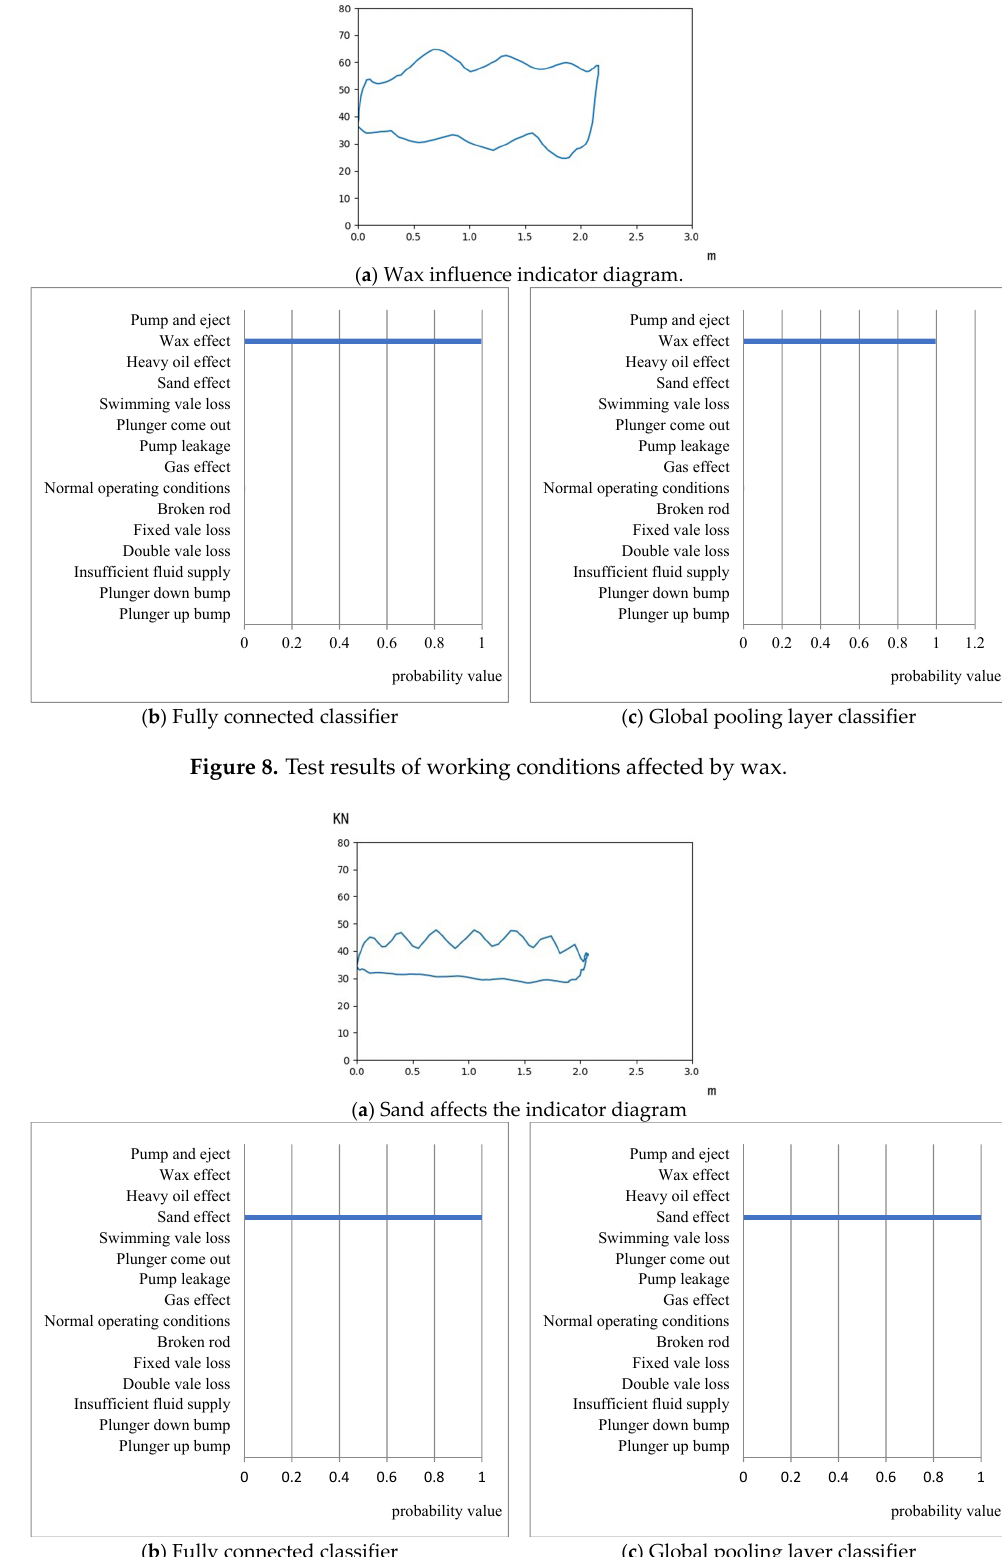
Figure 9. Sand affects the test results of working conditions.